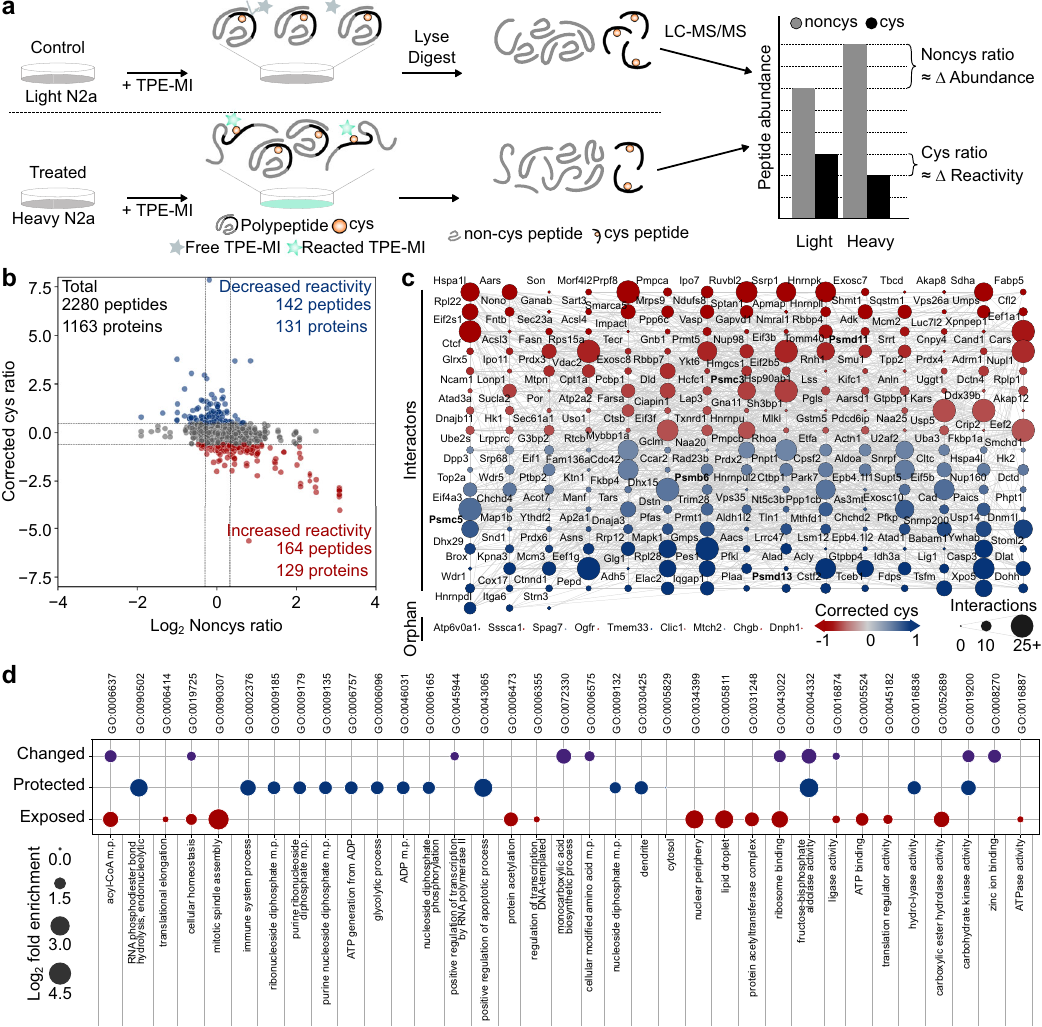
Fig. 2 Conformational changes due to proteasome inhibition re fl ect cellular responses to MG132. a Method schematic for quantifying proteome conformation via proteomics. SILAC-labeled Neuro-2a cells were treated with pharmacological stimuli i.e., MG132 (heavy) or vehicle control DMSO (light), then labeled with TPE-MI and prepared for proteome analysis using LC-MS/MS. Peptide quantitation yielded the relative abundance of noncys-containing peptides (a measure of abundance) and cys-containing peptides (a measure of conformational status). b Representative scatterplot for processed noncys- and corrected cys-peptide abundance ratios in the presence of proteasome inhibitor MG132. Dots show per-peptide summary values across four biological replicates. Thresholds (red dotted lines) determined based on the control dataset are shown, outside which cysteine-containing peptides were considered more exposed (red) or more protected (blue). c Protein interaction network for changed peptides derived from b . Protein nodes are colored according to maximum corrected cys ratio and edges (lines) connect proteins with a known interaction (STRINGdb v 11.0, medium con fi dence score >0.4). Protein nodes are sized according to the number of interactions within the network. d Signi fi cantly enriched gene ontology terms ( p < 0.05) for all proteins which changed reactivity (purple); or, more speci fi cally, became protected (blue) or exposed (red) in b . Enrichment terms are fi ltered to minimize hierarchical redundancy (PantherGOSlim v 16.0). Source data are provided as a Source Data fi (Fig. 4c, d). We fi rst considered proteins annotated with the generic gene ontology term “ protein-containing complex ” (GO: 0032991) and found that these proteins were signi fi cantly more correlated with each other than with non-complex proteins (Fig. 4c; two-tailed t -test, p < 0.001). Exploiting the hierarchical nature of gene ontology annotations, we then compared the average correlation among proteins for individual complexes which fall under the protein-containing complex umbrella (Fig. 4d). We identi fi ed several complexes for which reactivity changes were signi fi cantly correlated, including transcription, translation, and degradation machinery. This fi nding suggests at least some of the changes in reactivity we observe are a result of the assembly and/or disassembly of individual macromolecular complexes.